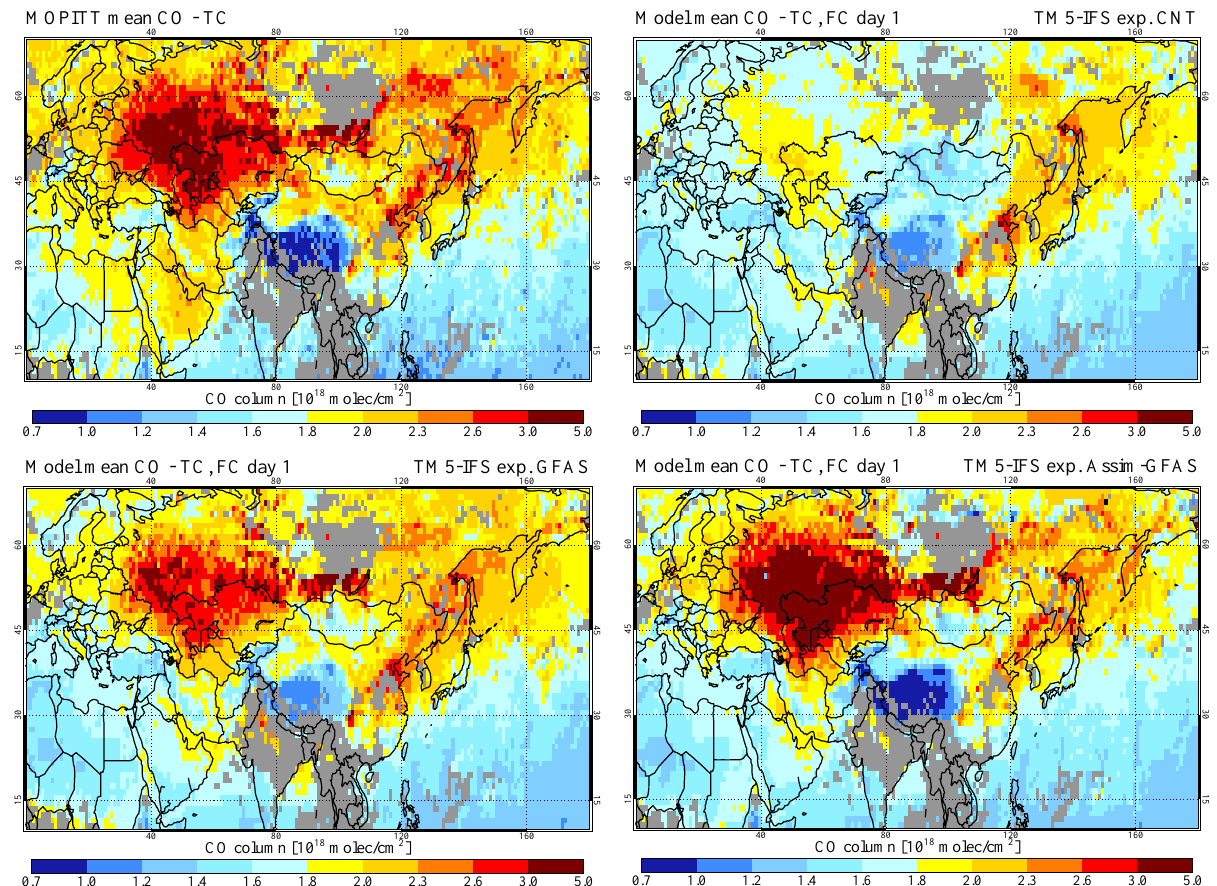
Fig. 5. Maps of mean CO columns from MOPITT-V4 for the time period 20 July–15 August 2010 compared to the kernel-weighted D+0 CO columns from the runs CNT, GFAS and Assim-GFAS.